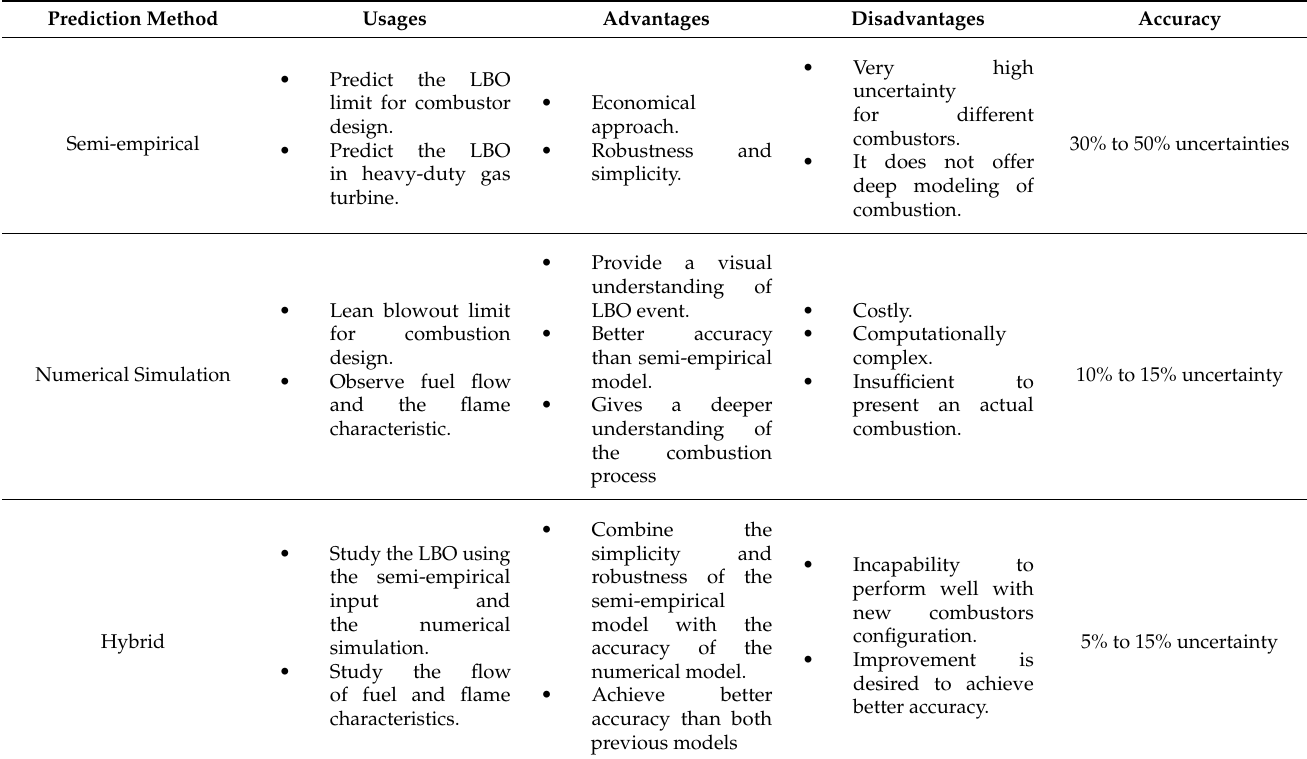
Table 5. Comparison of the LBO prediction techniques.